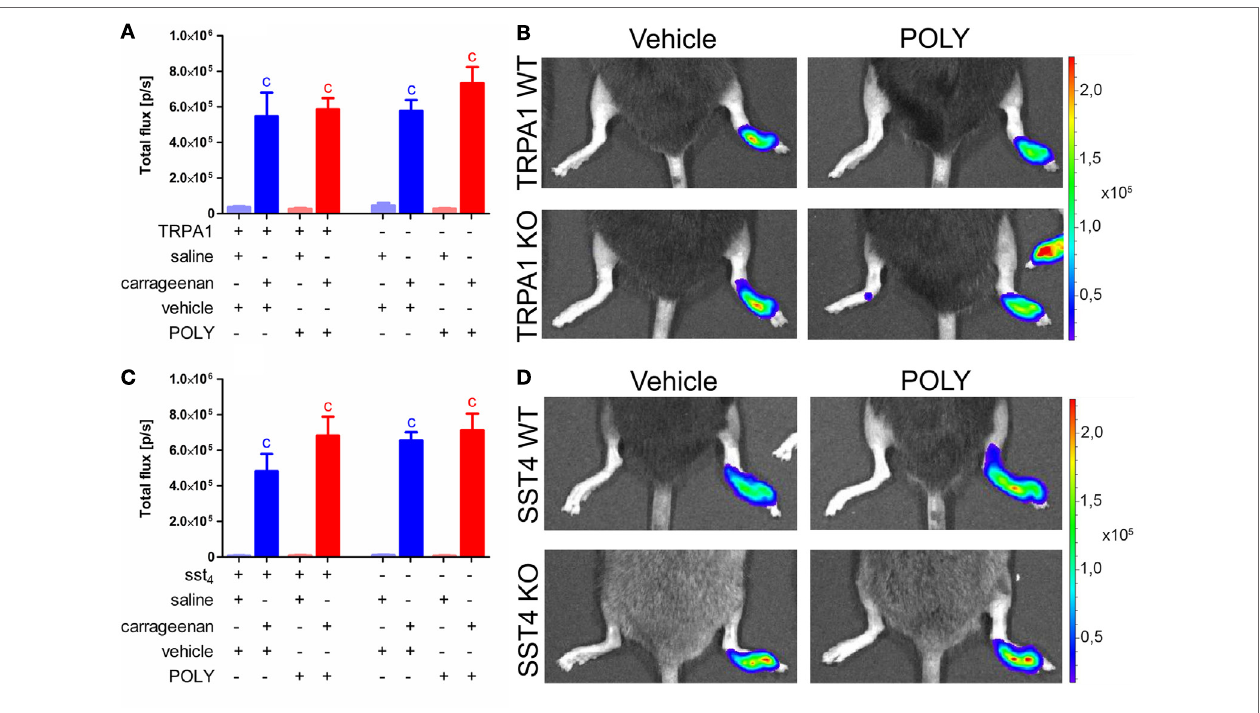
FigUre 5 | Polysulfide (POLY) treatment (17 µmol/kg, i.p.) does not alter myeloperoxidase (MPO) activity shown by luminol bioluminescence in murine hind paws with carrageenan-induced inflammation. (a) Bioluminescence in saline and carrageenan-injected (3% in 20 µL saline) hind feet of transient receptor potential ankyrin 1 (TRPA1) WT and KO animals. (B) Representative bioluminescent images of saline and carrageenan-treated (3% in 20 µL saline) hind paws of TRPA1 WT and KO mice illustrating MPO activity. (c) Luminol bioluminescence in saline and carrageenan-treated (3% in 20 µL saline) hind feet of sst4 receptor WT and KO mice. (D) Representative bioluminescent images of saline and carrageenan-treated (3% in 20 µL saline) hind paws of sst4 WT and KO animals. Data are shown as mean ± SEM. n = 7–8. c p < 0.05 vs. saline-injected paws. One-way ANOVA followed by Bonferroni’s multiple comparison